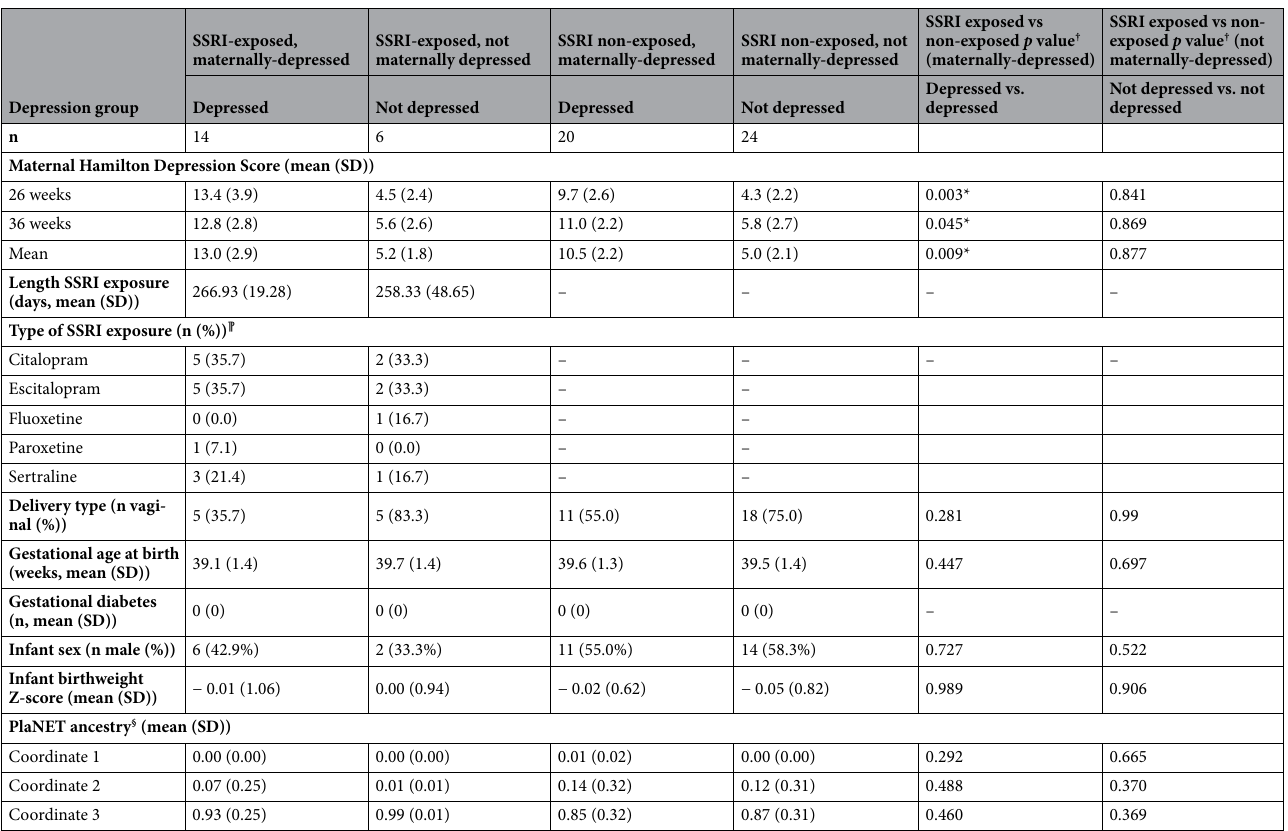
Table 2. Discovery cohort demographics by SSRI and depression group status. Maternal depression was categorized using mean maternal Hamilton Depression score, ≤ 8 was categorized as not depressed, > 8 as depressed, this is reflected in the “Depression Group” row. SSRI refers to selective-serotonin reuptake inhibitor treatment during pregnancy. Birthweight Z scores were calculated using gestational-age and sex-adjusted birthweight curves 45 . † p values are from chi-squared tests for categorical variables and t-tests for continuous variables, * indicates < 0.05, ** indicates < 0.005. ⁋ p = 0.59 (chi-squared test) for proportion of SSRI